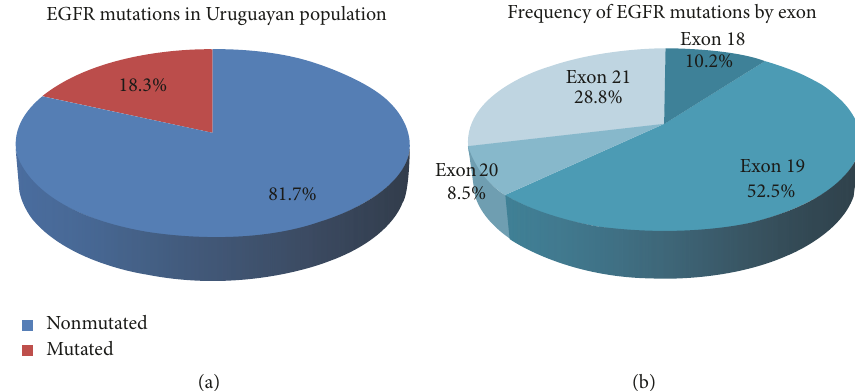
Figure 1: (a) shows overall EGFR mutations in Uruguayan population. (b) shows distribution by exon of EGFR mutations.